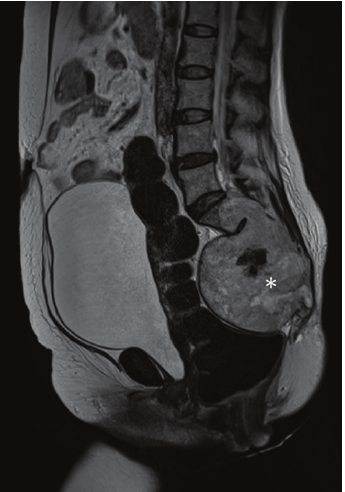
Figure 1: MRI scan of the large chordoma (white star) of the sacrum: T2-weighted sagittal image.